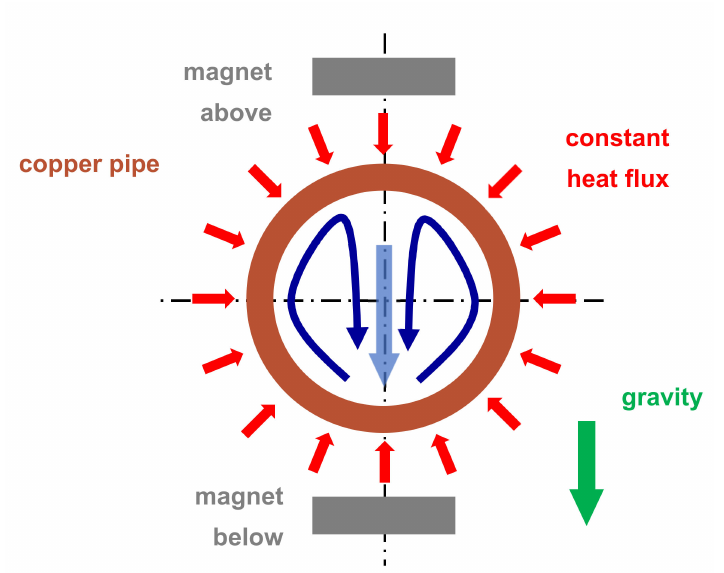
Figure 3. Flow situation for mixed convection (water) without magnetic influence. The main flow points into the plane of drawing. The secondary motion (counter rotating vortex pair) is shown in blue and the centrally positioned down flow by the light-blue arrow. The magnets are shown only to illustrate their position with respect to the pipe and the secondary motion. Sketch not to